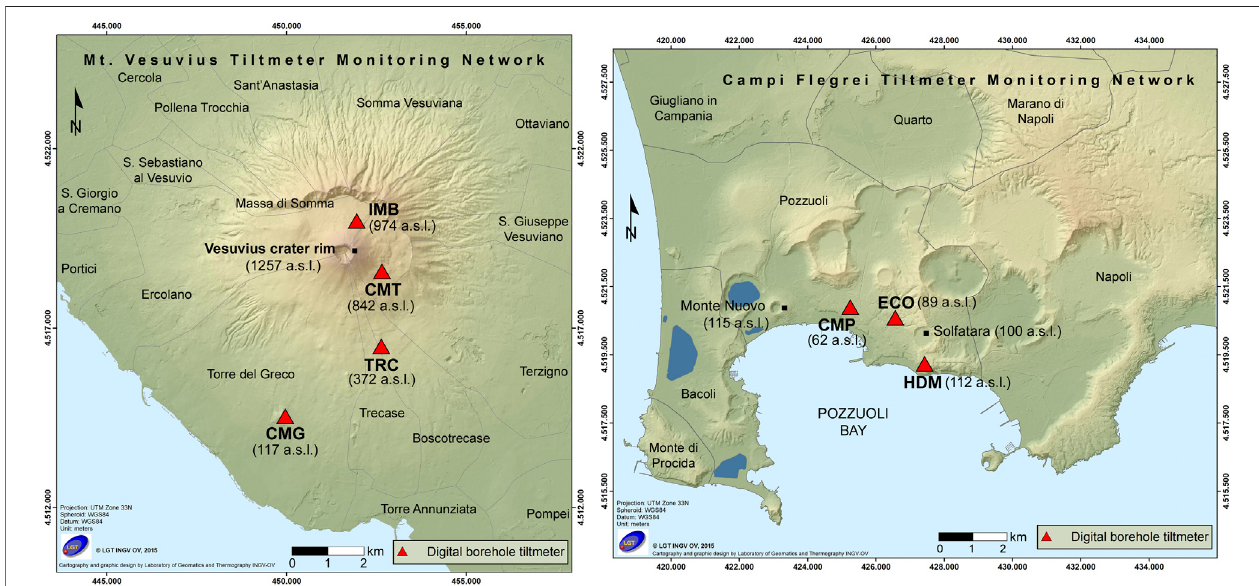
FIGURE 1 | Map of Vesuvius (A) and Campi Flegrei (B) with the location of the borehole tiltmeters. The base maps were created by the INGV-OV Laboratory of Geomatics and Thermography, © LGT INGV OV, 2015.